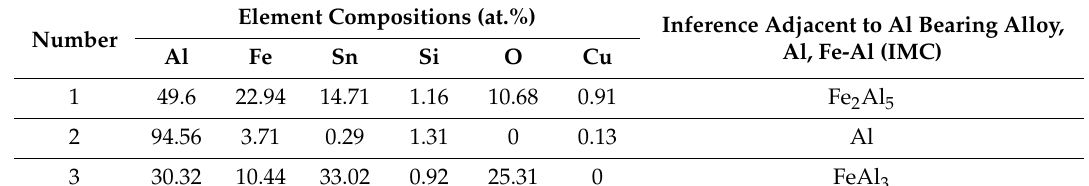
Table 2. EDS analysis corresponding to the points 1, 2 and 3 indicated in Figure 5.